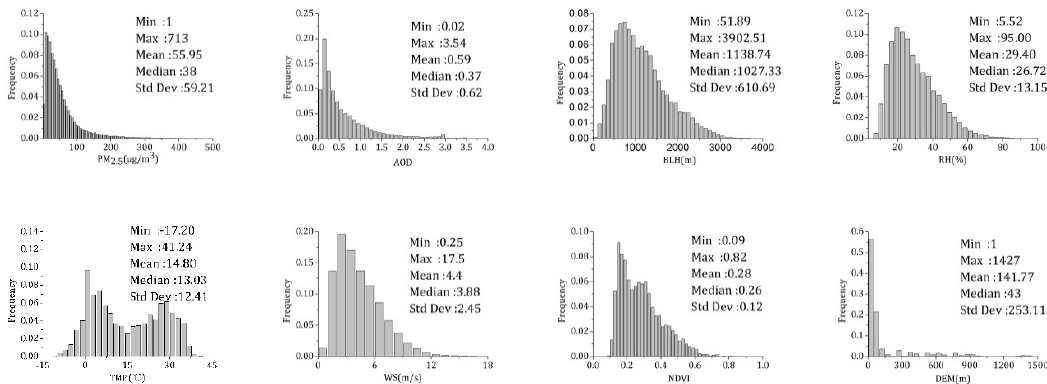
Figure 3. Histograms and descriptive statistics (minimum, maximum, mean, median, and standard deviation values) of dependent and independent variables for the Moderate Resolution Imaging Spectroradiometer (MODIS).